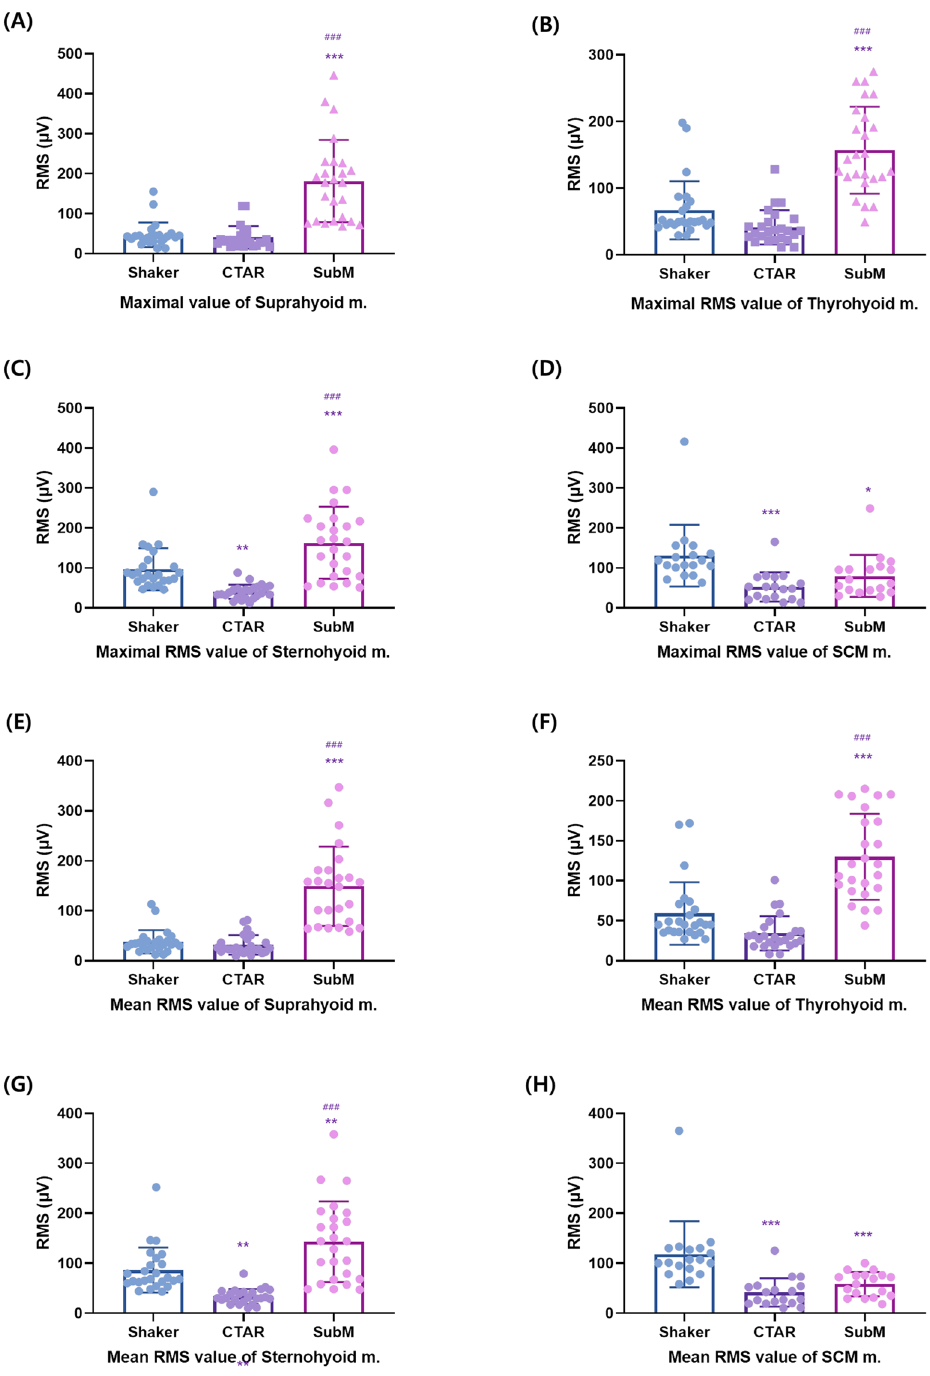
Figure 3. The maximum ( A – D ) and mean ( E – H ) RMS values of the suprahyoid, thyrohyoid, sternohyoid, and SCM muscles in healthy participants. The graphs were drawn using GraphPad Prism 8.0. RMS, root mean square; SCM, sternocleidomastoid. Compared with the Shaker exercise: * p < 0.05, ** p < 0.01, *** p < 0.001; compared with the chin tuck against resistance exercise: # p < 0.05, ## p < 0.01, ### p <